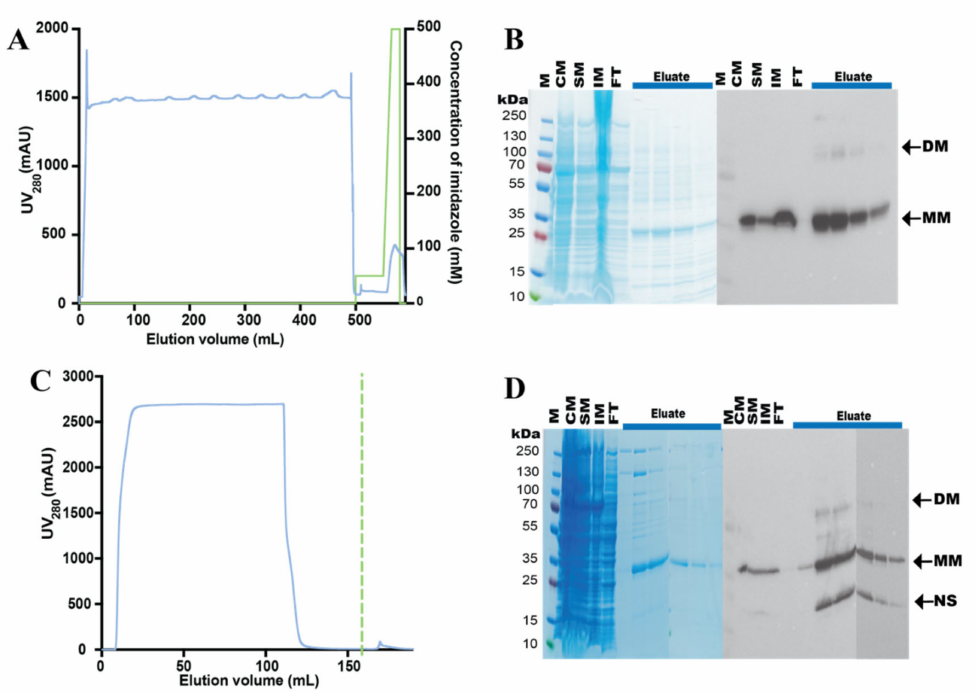
Figure 5. Purification of N-terminal hZIP1 fusions. Crude membranes isolated from Saccharomyces cerevisiae cells (derived from 12-L cultures) expressing ( A , B ) His-TEV-hZIP1 and ( C , D ) StrepII-TEV-hZIP1 (68-h induction at 15 ◦ C) were solubilized in 2% ( w / v ) DDM + 0.2% ( w / v ) CHS for 2 h at 4 ◦ C. Following solubilization, affinity-based purification was performed. CHS: cholesteryl hemisuccinate Tris salt. ( A ) Immobilized metal affinity chromatography (IMAC) of His-TEV-hZIP1. IMAC profile indicates UV 280 signal for protein (blue) and concentration of imidazole applied at each step of the affinity purification (green). ( B ) Coomassie staining (left) and immunoblot probed with 6 × His mAb-HRP conjugate (right) of SDS-PAGE-separated samples collected during IMAC purification. M: marker; CM: crude membranes; SM: solubilized membranes; IM: insoluble material; FT: IMAC flow-through; Eluate: IMAC peak fractions eluted with imidazole gradient. Arrows indicate the monomeric (MM) and dimeric (DM) forms of purified His-TEV-hZIP fusion, with the predicted MWs of the respective forms of 32.5 kDa (MM) and 65 kDa (DM). ( C ) StrepII-tag affinity chromatography of StrepII-TEV-hZIP1. The profile indicates UV 280 signal for protein (blue). Green dashed line indicates the starting point of the elution phase with 50 mM biotin. ( D ) Coomassie staining (left) and immunoblot probed with Strep-Tactin ® HRP conjugate (right) of SDS-PAGE-separated samples collected during StrepII-tag affinity purification. Letter code of the analyzed samples is to identical to ( B ). Arrows indicate the monomeric (MM) and dimeric (DM) forms of purified StrepII-TEV-hZIP fusion, with the predicted MWs of the respective fusions of 36.5 kDa (MM) and 73.0 kDa (DM). NS: nonspecific band/degradation